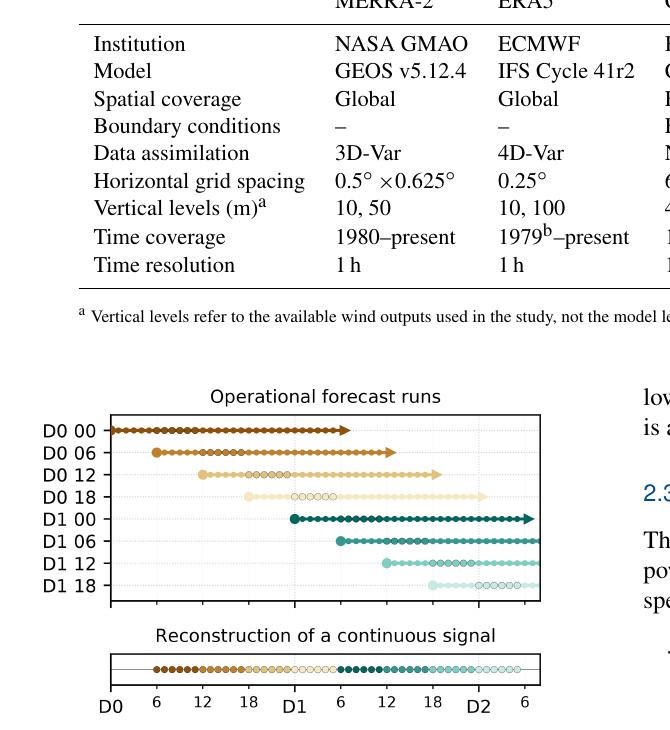
Figure 1. Schematic of the reconstruction of a continuous hourly signal by selecting 6 steps ( + 6 to + 11h here) in each forecast run from an operational NWP model issuing a new forecast every